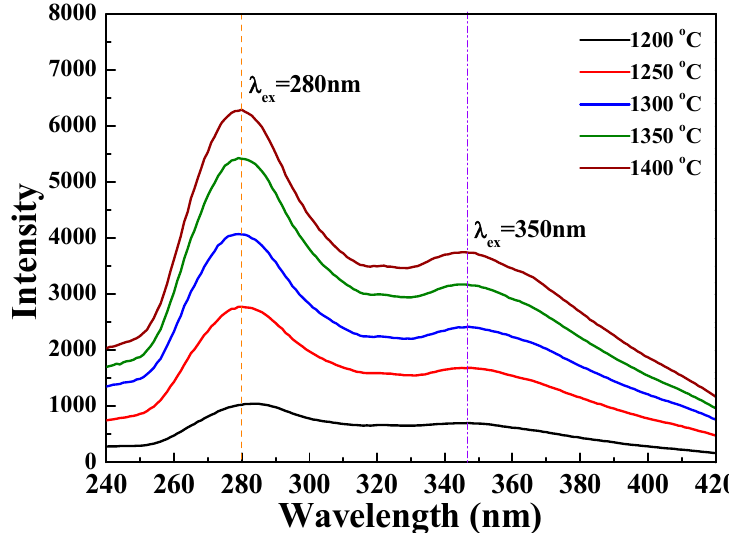
Figure 11. PLE spectra of the [Sr 0.99 Eu 0.01 ] 3 MgSi 2 O 8 phosphors sintered at different temperatures.